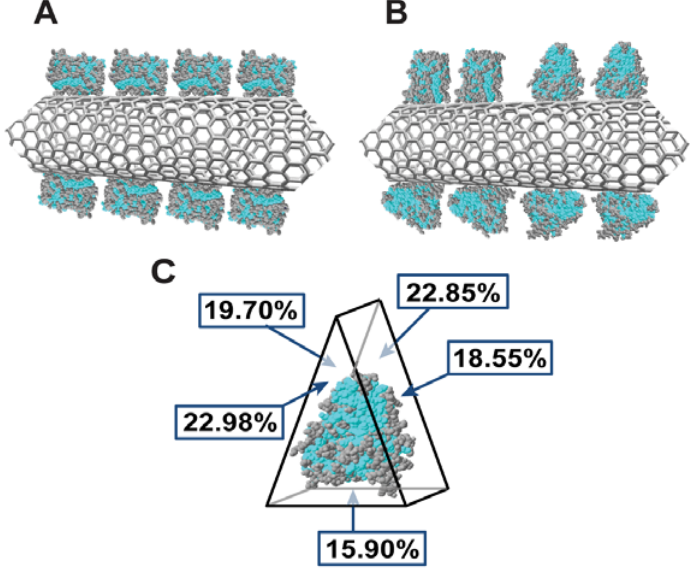
Figure 2. Orientation of microsomal cytochrome P450 3A4 on carbon nanotubes and its crystallographic structure. Figure 2(A) represents the most likely orientation of cytochrome onto the carbon nanotube according to the percentage of hydrophobic sites reported in Figure 2(C). A distinct triangular prismatic shape is evident, while the hydrophobic residues are highlighted in blue. For the construction of the model for Monte Carlo simulations, it has been assumed that cytochrome molecules mainly expose their larger face ( i.e. , the lateral face, Figure 2(A)), for hydrophobic interaction with carbon nanotubes walls, since it is not possible to predict the right protein orientation onto the nanotube walls. Figure 2(B) represents four other possible orientations of cytochrome onto the carbon